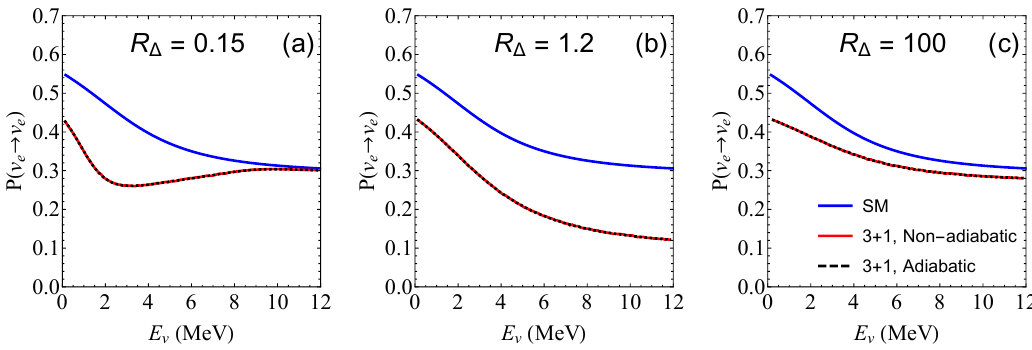
Figure 5 . Survival probabilities as a function of solar neutrino energy for sin 2 2 θ 01 = 0 . 5 . The solid blue and solid red lines correspond to numerical results in the 3 ν and 3+1 cases, respectively. The black dotted line is the analytical solution in the 3+1 case under the assumption of adiabatic propagation. Other oscillation parameters are the same as those in figure